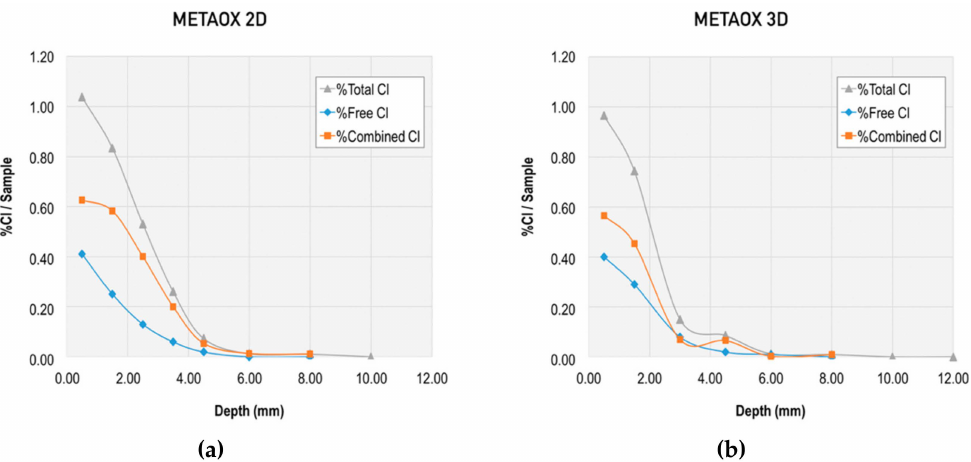
Figure 8. Total, free, and combined chloride content in METAOX mix at early ages: ( a ) at two days and ( b ) at three days.